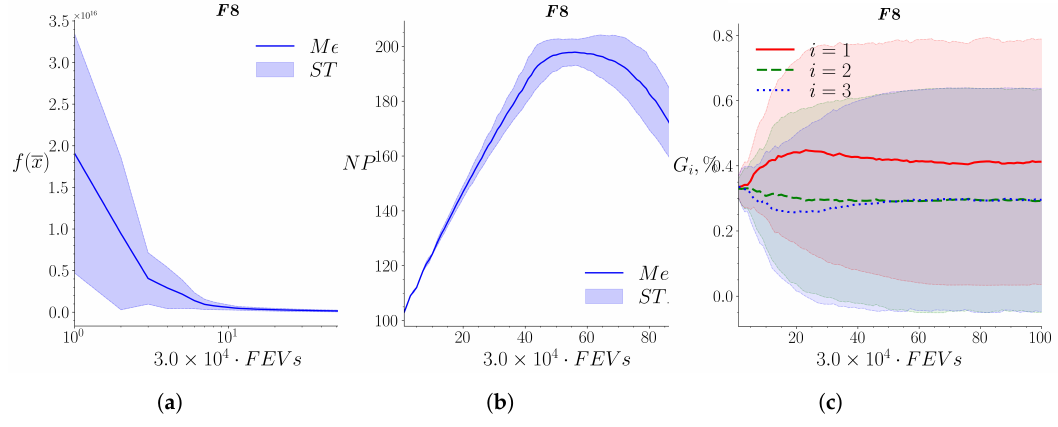
Figure A8. The dynamics of COSACC-LS1 on the F8 problem: ( a ) Convergence; ( b ) Population size;